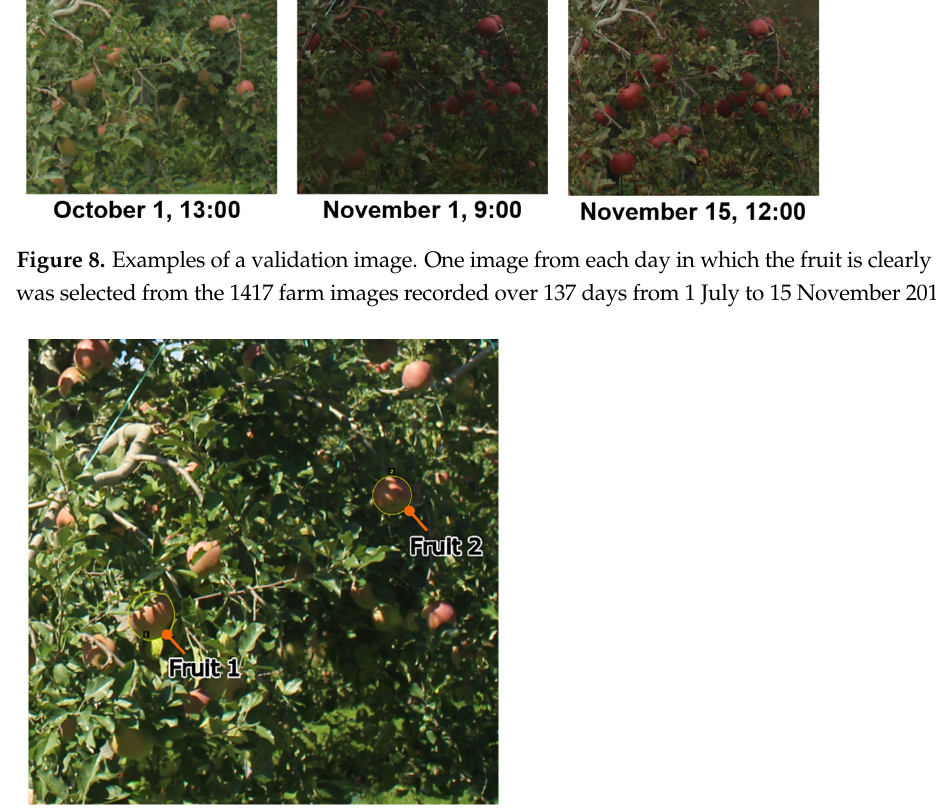
Figure 9. Target fruits to detect. Two fruit types (Fruit 1 and Fruit 2) in the farm image were targeted. Fruit 1 was partially hidden by leaves and other fruit in all images, while fruit 2 was partially hidden by leaves and other fruit in 23 of the 1417 images, which are several images per day ranging from 32 to 49 elapsed days.